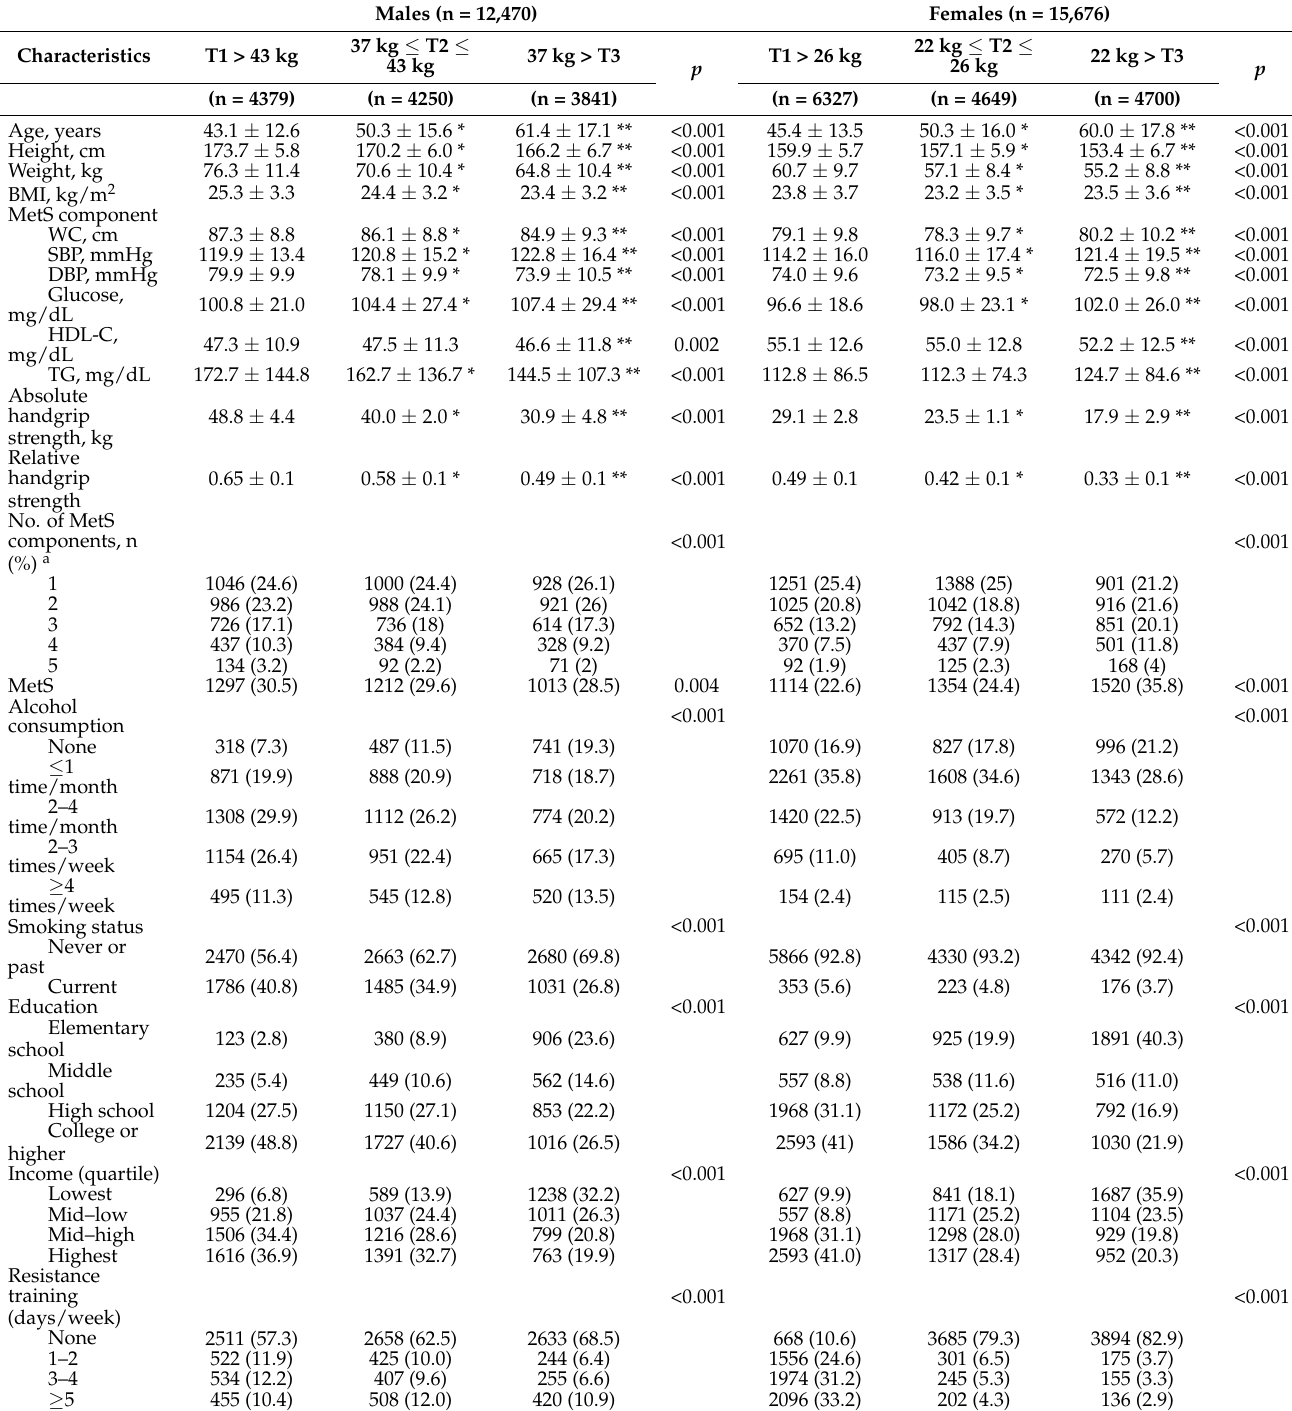
Table 1. Characteristics of participants by tertile of absolute handgrip strength, stratified by sex. Males (n = 12,470) Females (n =